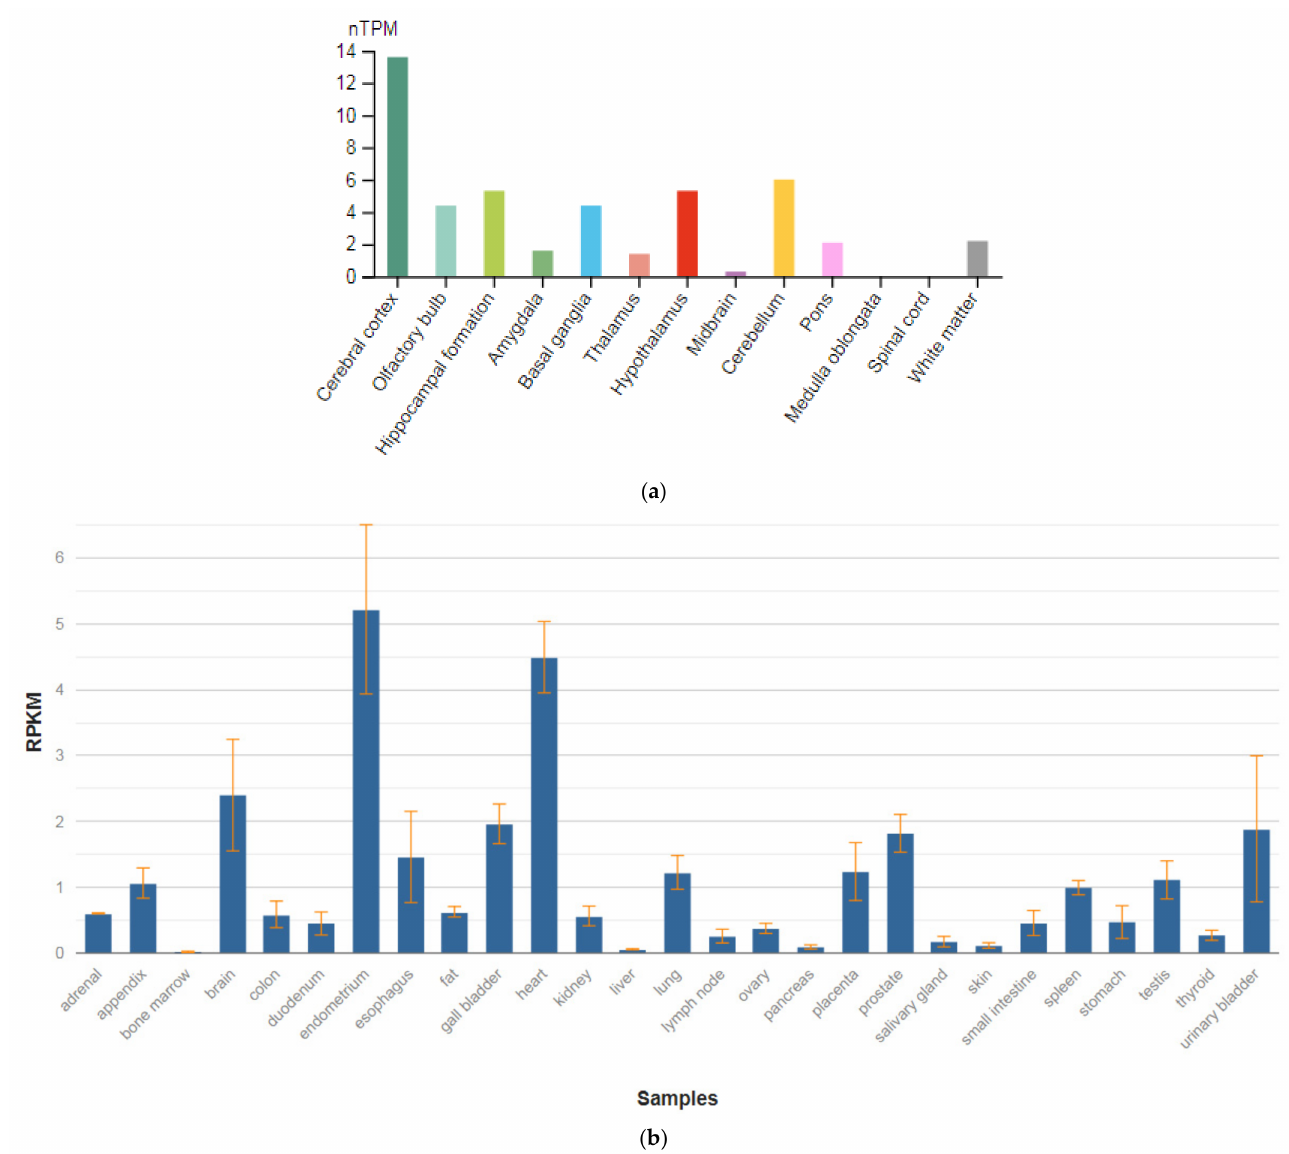
Figure 8. The tissue expression of the calcium voltage-gated channel auxiliary subunit β 2 in the brain ( a ) and other organs in the human body ( b